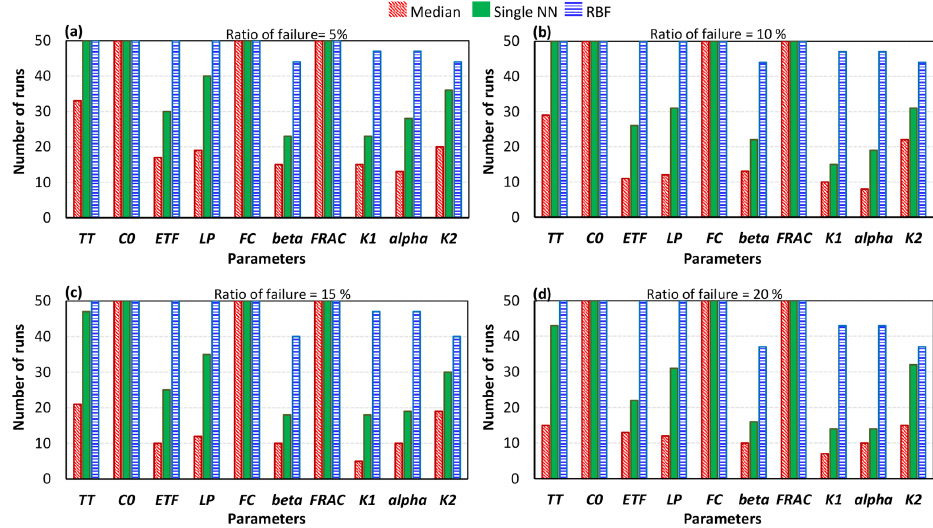
Figure 8. Comparison of the crash-handling strategies in estimating the parameter rankings for the HBV-SASK model using the variance- based algorithm when the ratio of failure was (a) 5%, (b) 10%, (c) 15%, and (d) 20%. The y axis in each subplot shows the number of times out of 50 replicates that the rankings of the parameters were equal to the true ranking.